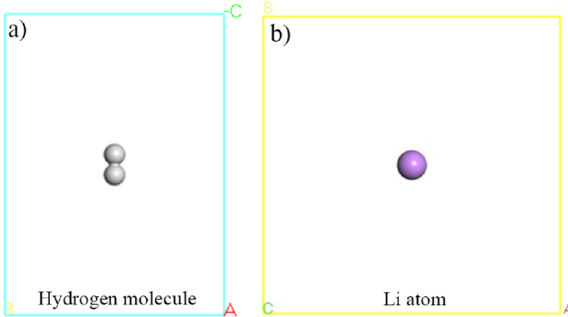
Figure 1. Computation models of hydrogen molecule and Li atom.